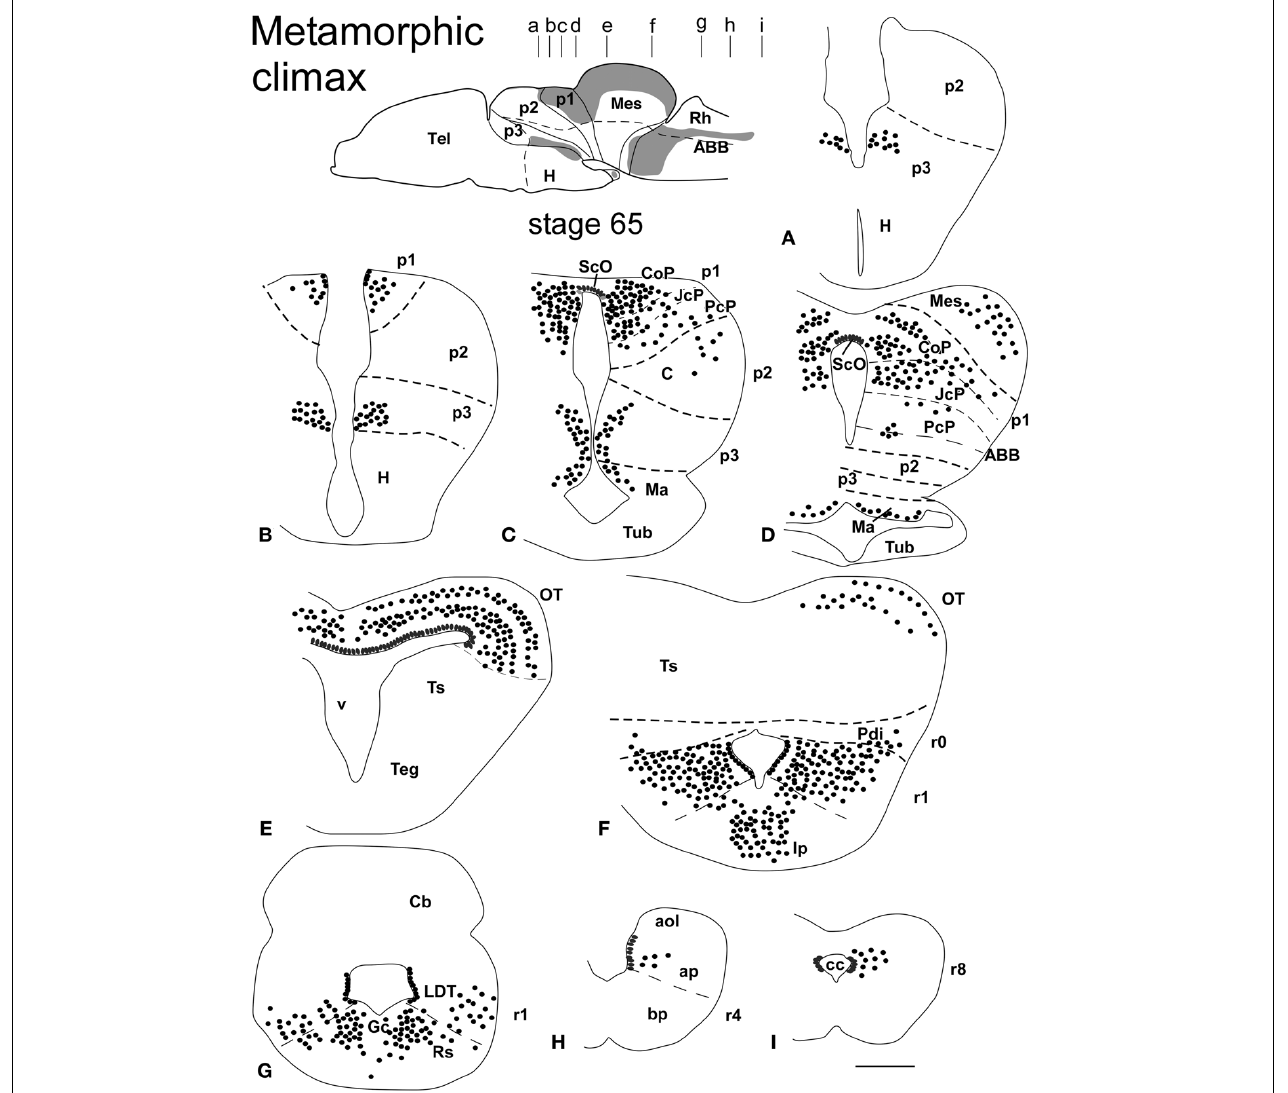
FIGURE 3 | Schematic drawings of transverse sections through the brain of Xenopus laevis at the metamorphic climax stage 65 (A–I) showing the distribution of Pax7 immunoreactive cells. The levels of the sections are